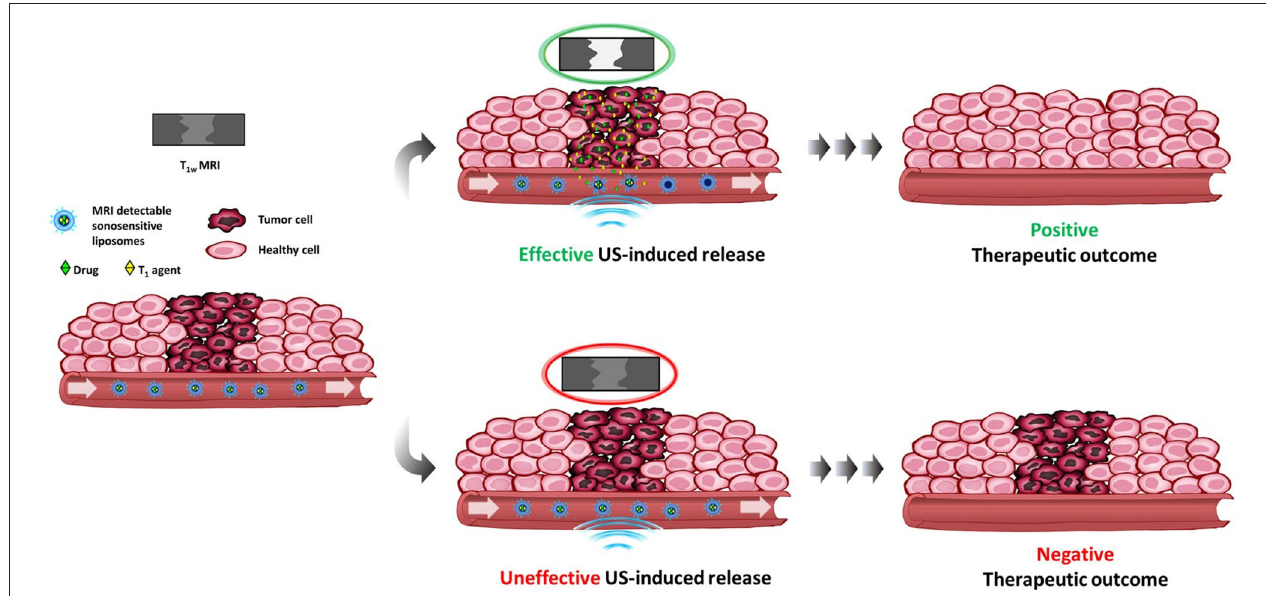
FIGURE 1 | Schematic view of a theranostic protocol using MRI-detectable sonosensitive chemotherapeutic liposomes. If effective, the ultrasonic stimulus applied on the tumor triggers the release of both drug and MRI T 1 agent with consequent contrast enhancement and positive therapeutic outcome. The lacking of contrast enhancement gives an immediate information on the ineffectiveness of the stimulus, which would result in a negative outcome, thus allowing to find a remediation (repeat the stimulation, change therapeutic protocol,